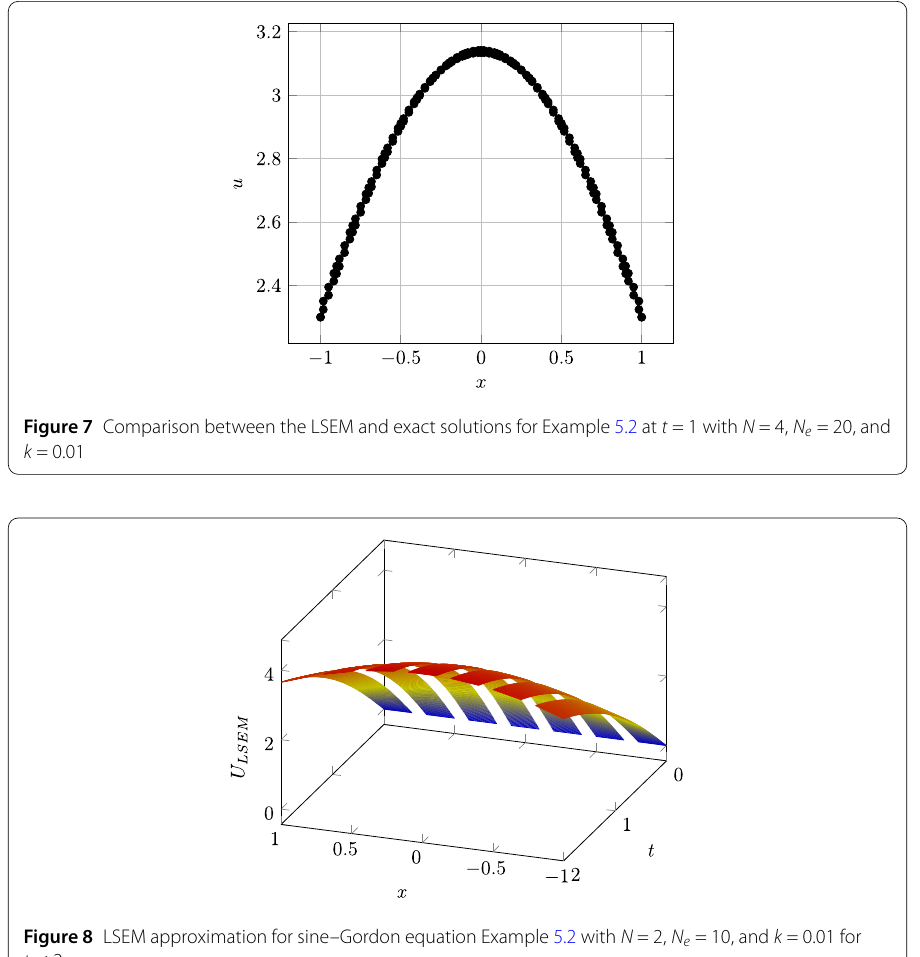
Figure 8 LSEM approximation for sine–Gordon equation Example 5.2 with N = 2, N e = 10, and k = 0.01 for t ≤